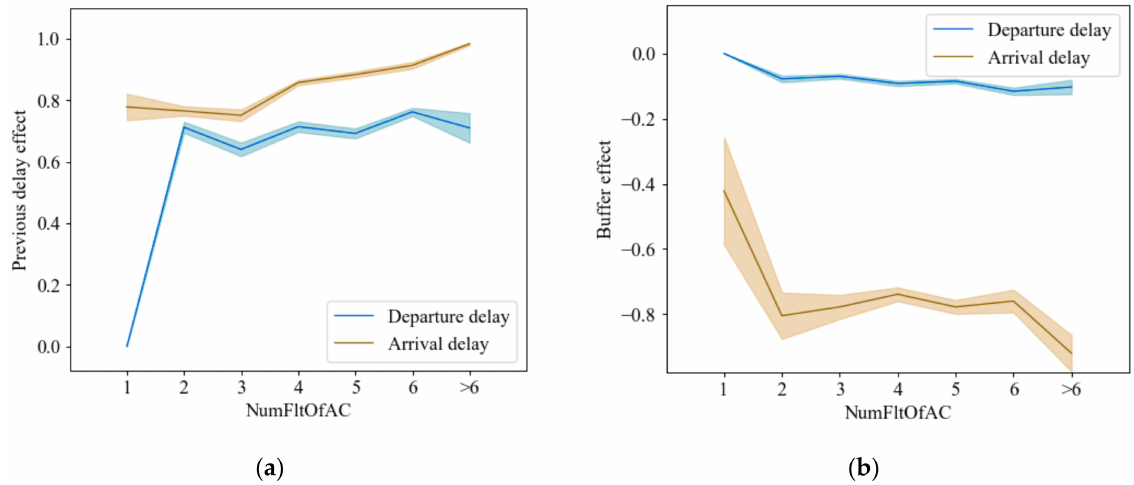
Figure 5. Delay propagation effect variation with NumFltOfAC. ( a ) Previous delay effect against NumFltOfAC. ( b ) Buffer effect against